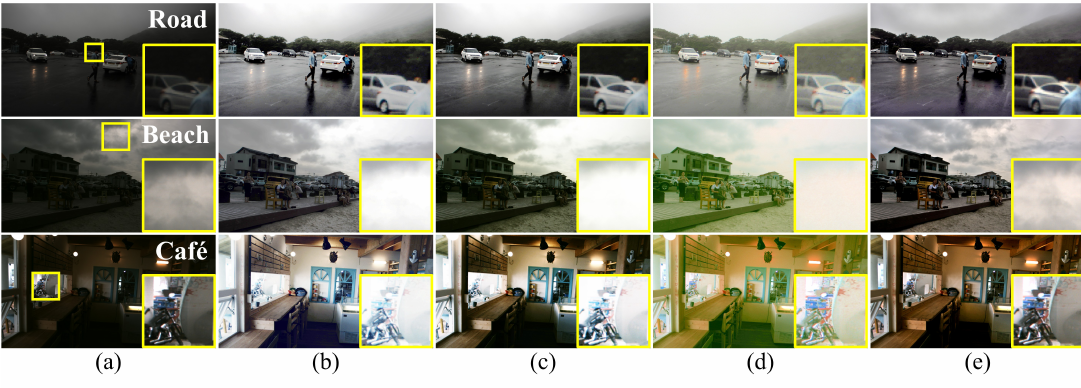
Figure 15. Resulting enhanced images of the existing and proposed methods using real low-light images: ( a ) input image, ( b ) HE [26], ( c ) Huang’s method [27], ( d ) Jiang’s method [25], and ( e ) the proposed method. Table 5. The objective quality assessments of the real low-light image enhancement using the autoregressive-based image sharpness metric (ARISM) [30]. Input [26] [27] [25] Proposed ARISM ARISM ARISM ARISM ARISM